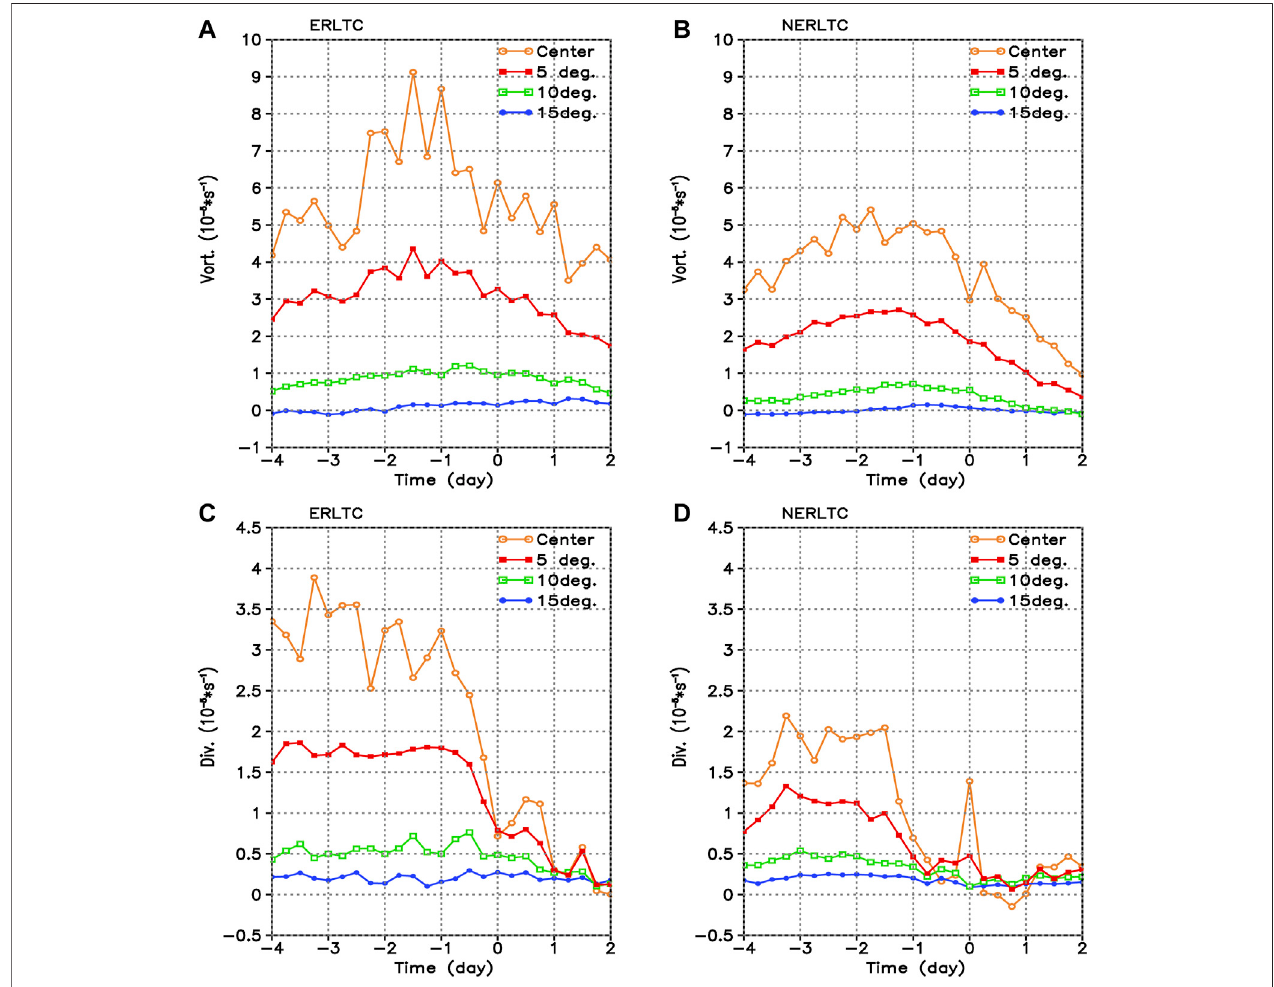
FIGURE4| Temporalvariationsoftheregional-averagerelativevorticity(units:10 – 5 s − 1 )at850 hPa (A,B) andthedivergence(units:10 – 5 s − 1 )at200 hPa (C,D) for ERLTCs (A, C) and NERLTCs (B, D) . The abscissa represents the relative time in days to the occurrence of the rainfall during the study period (unit: days), which is the same in the following fi gures.